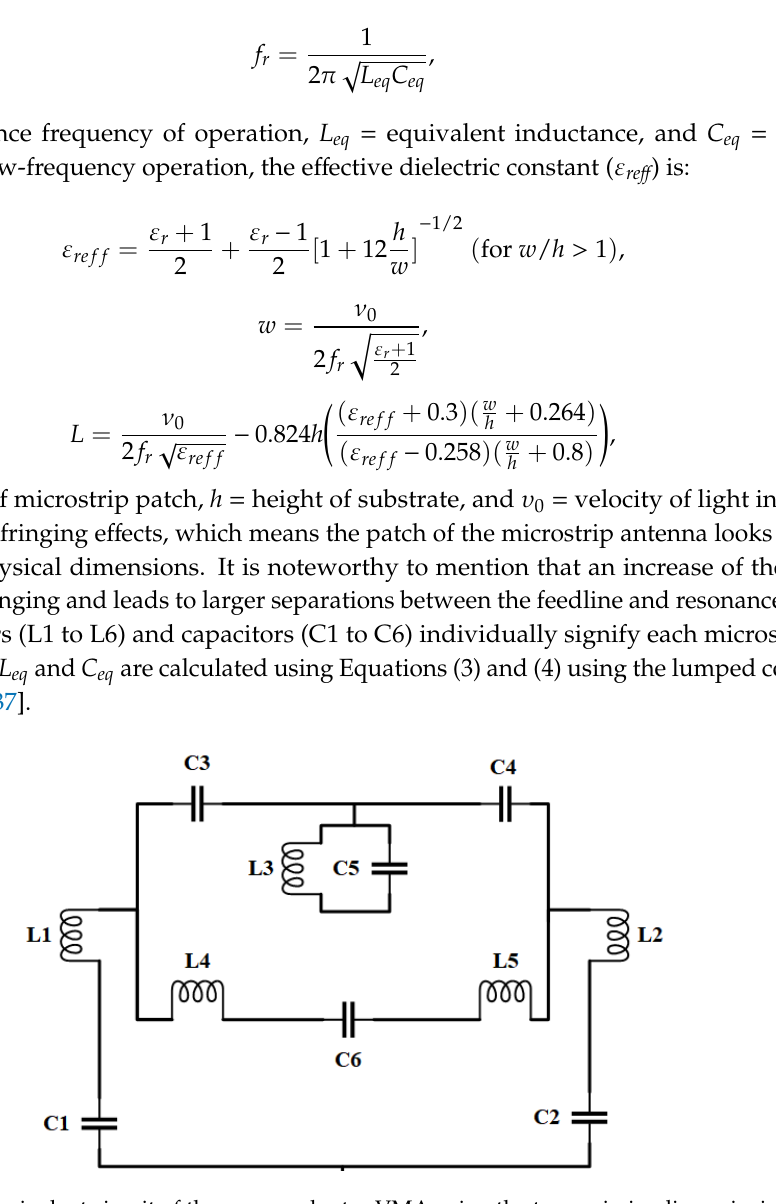
Figure 2. Equivalent circuit of the proposed retro VMA using the transmission line principle.